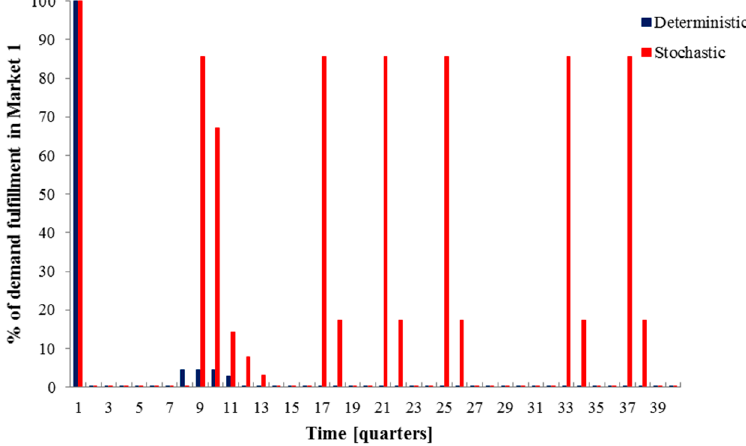
Figure 15. Variation of % of demand fulfilment in Market 1 for both deterministic (base case) and stochastic cases during the planning horizon.